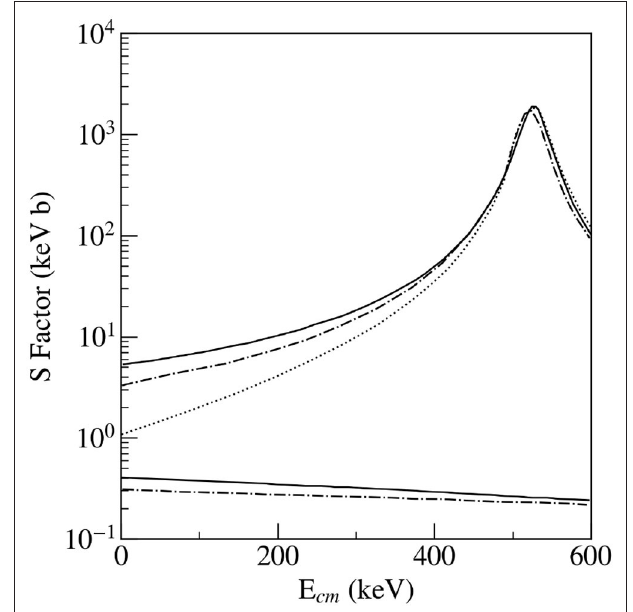
FIGURE 14 | The astrophysical S-factor for the 13 N(p, γ ) 14 O capture. The relatively flat solid line is the direct capture contribution determined from the ANC. This result is higher than that obtained by Decrock et al. (1993) (lowest dash-dotted line). Based on constructive interference, this updated result for the total S-factor, the top solid line, is about 38% higher than the previous result (upper dash-dotted line). For the sake of completeness, the result with destructive interference is shown (the dotted